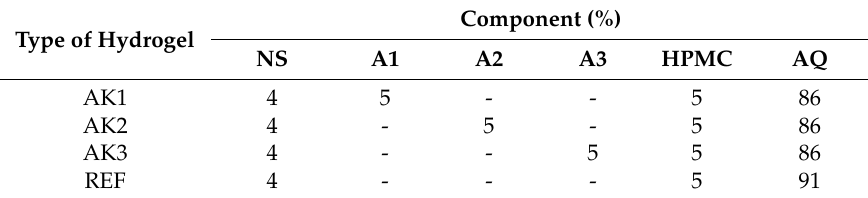
Table 6. Compositions of hydrogels AK1–AK2 with the synthesized particles and reference